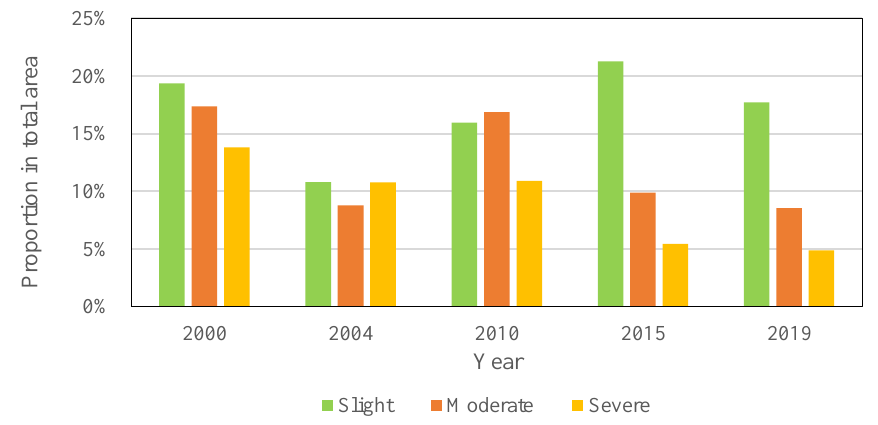
Figure 11. Proportions of the ADL area at all levels.